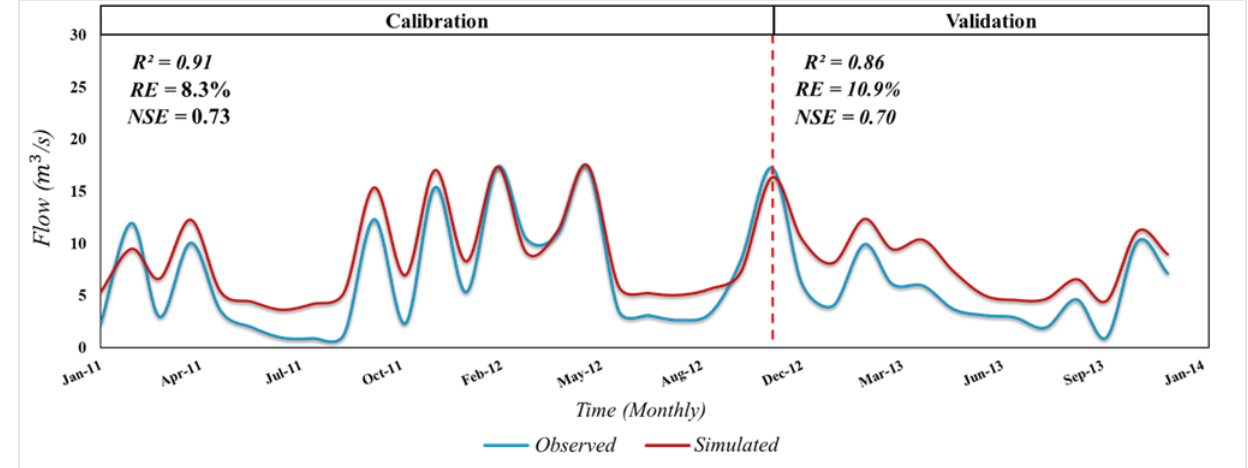
Figure 5. Observed and simulated streamflow during the calibration and validation.